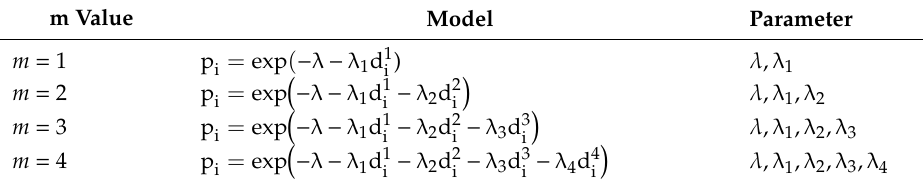
Table 2. Maximum entropy (MaxEnt) model of stand diameter